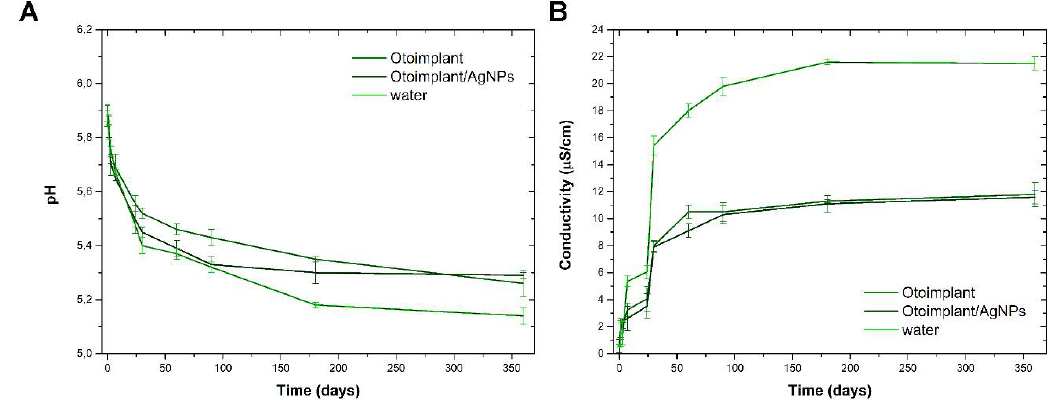
Figure 5. pH and conductivity changes of deionized water during 3-, 6-, and 12-month incubation of Figure 5. pH ( A ) and conductivity ( B ) changes of deionized water during 3-, 6-, and 12-month the Otoimplant and Otoimplant/AgNPs. incubation of the Otoimplant and Table 2. Antimicrobial efficacy of the Otoimplant and Otoimplant/AgNPs. CFU – colony-forming unit.